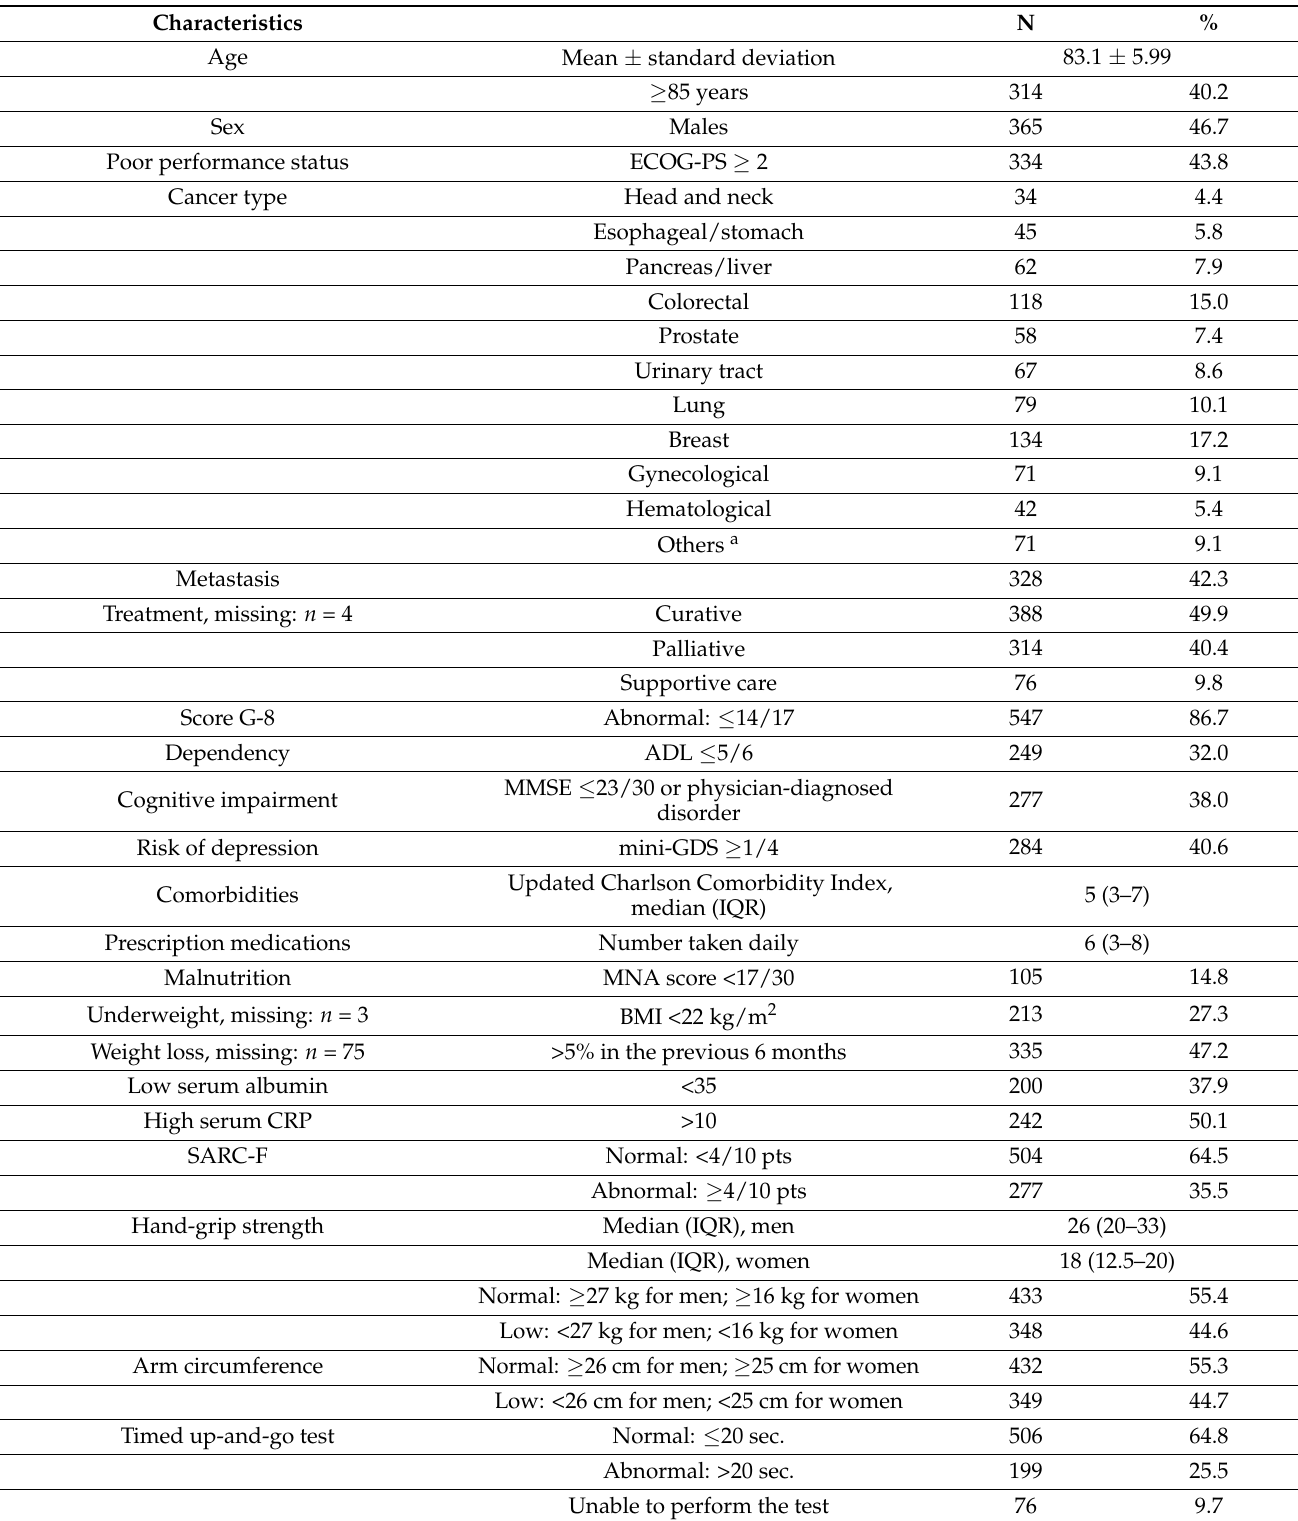
Table 1. Characteristics of the study population ( n =